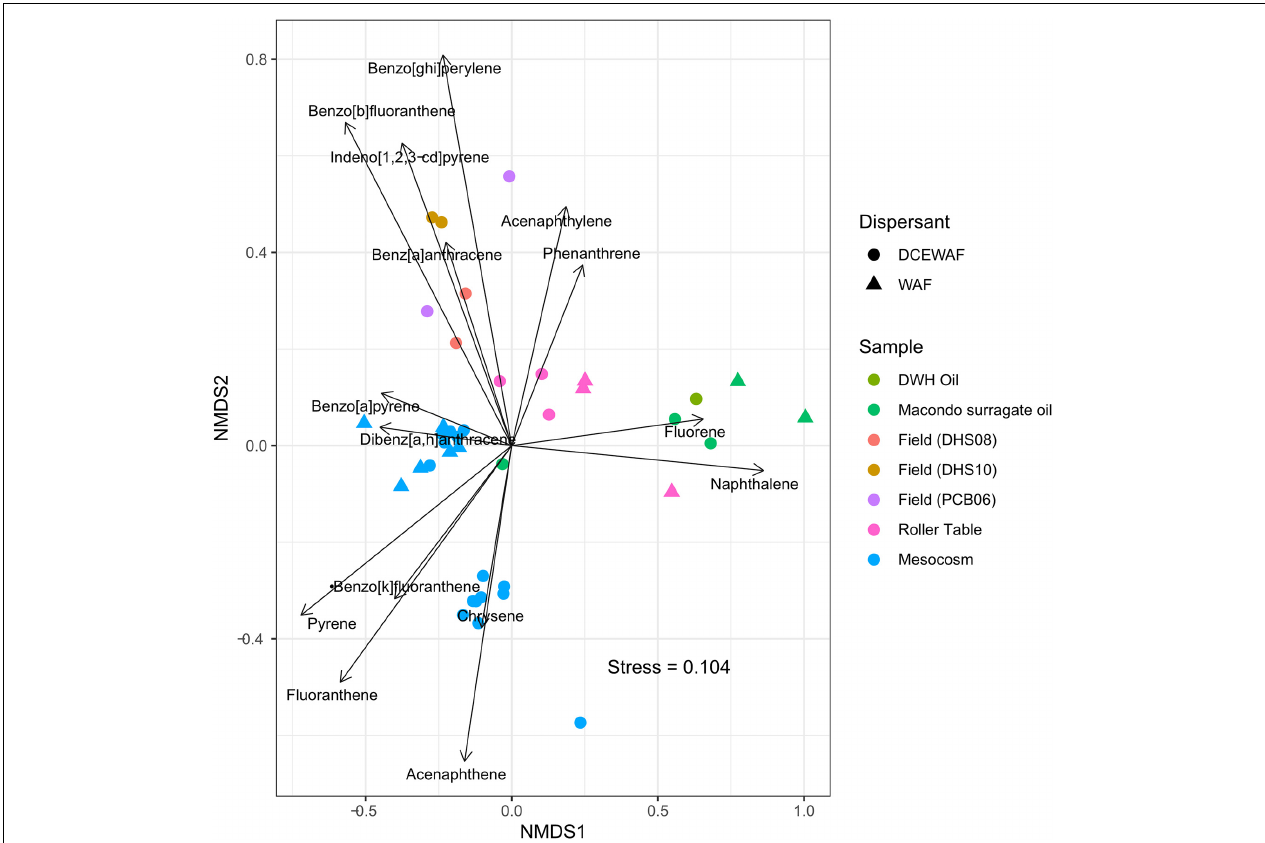
FIGURE 5 | Non-metric multidimensional scaling (NMDS) plot showing clustering of marine snow samples from various mesocosm, roller table studies and field sediment samples from Gulf of Mexico based on PAH composition. Data points clustered to the right are sample from the original Deepwater Horizon (DWH) Macondo oil and the Day 1 sample from surrogate oil used in the laboratory mesocosm and roller table studies, whereas the points clustered largely to the left are marine snow samples from the field and laboratory experiments. Only PAHs such as Naphthalene, Acenaphthylene, Acenaphthene, Fluorene, Phenanthrene, Anthracene, Fluoranthene, Pyrene, Benz[a]anthracene, Chrysene, Benzo[b]fluoranthene, Benzo[k]fluoranthene, Benzo[a]pyrene, Indeno[1,2,3-cd]pyrene, Dibenz[a,h]anthracene, and Benzo[ghi]perylene were used for the analysis, with concentrations of each PAH normalized to percentage of total PAHs in each sample. More details on the PAH extraction, sample collection, field site and design of the roller table and mesocosm studies can be found in Genzer et al. (2020); Bacosa et al. (2020), Romero et al. (2015) and GRIIDC dataset